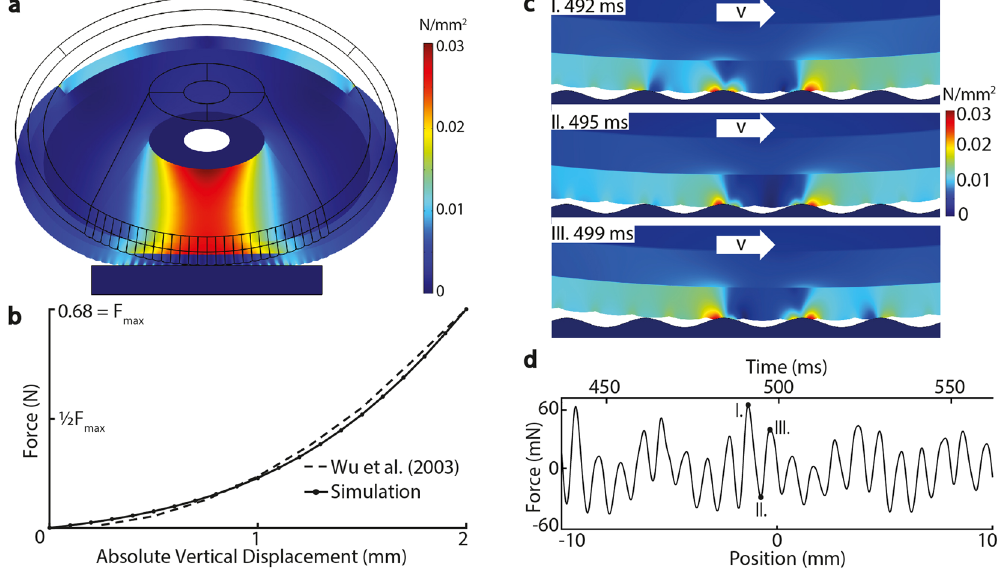
Figure 5. ( a ) The von Mises stress distribution at 2 mm displacement static loading of the fingertip against a rigid plate, illustrating high stress concentrations between bone and surface ( b ) The static nonlinear behavior of a real fingertip is effectively captured by the simulation, as shown by the force-displacement curves ( c ) Von Mises stress distribution for the condition ( λ = 1 mm, v = 80 mm/s) at the time instances I: 492 II: 495 III: 499 ms. High stress values are unevenly present in the contact region of the epidermal layer and attenuate with increasing distance to the finger surface interface. ( d ) Typical simulated force trial ( λ = 1 mm, v = 80 mm/s) as a function of time and space: the oscillating force signal exhibits quasiperiodic behavior with increasing and decreasing